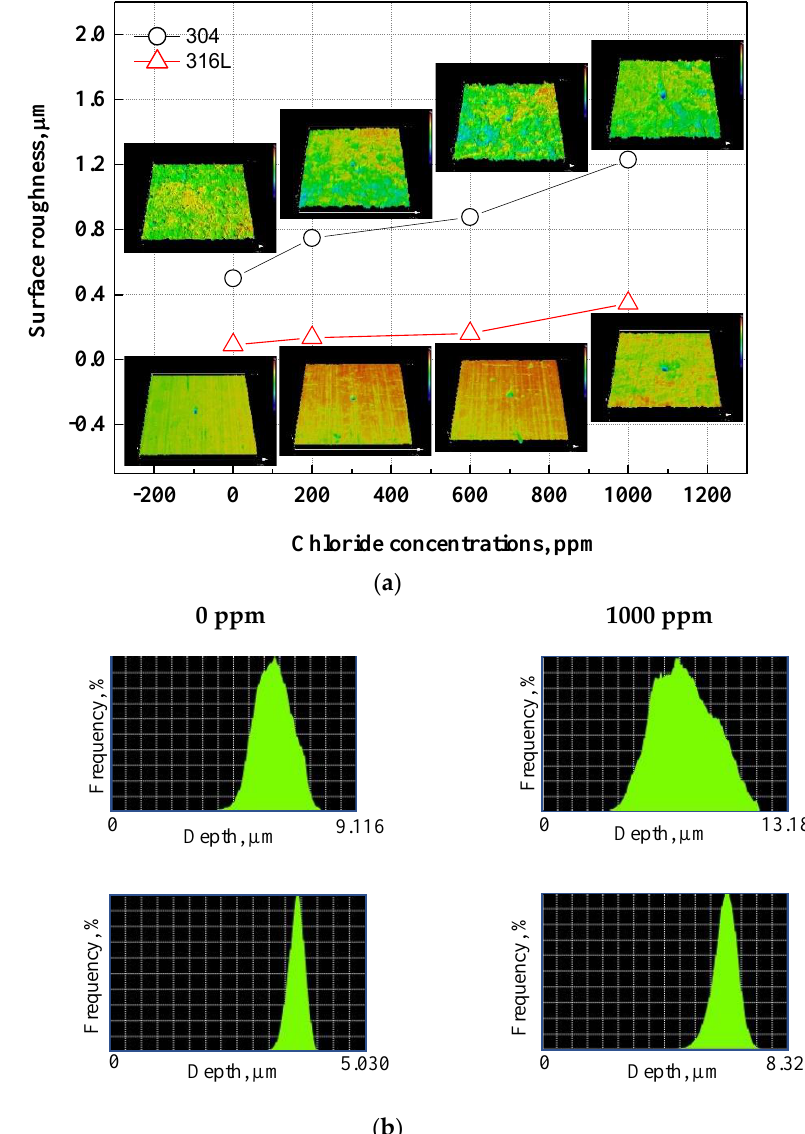
Figure 7. 3D analysis and surface roughness of damaged surfaces for 304 and 316L stainless steels after a potentiodynamic polarization experiment: ( a ) surface roughness; ( b ) depth histogram.